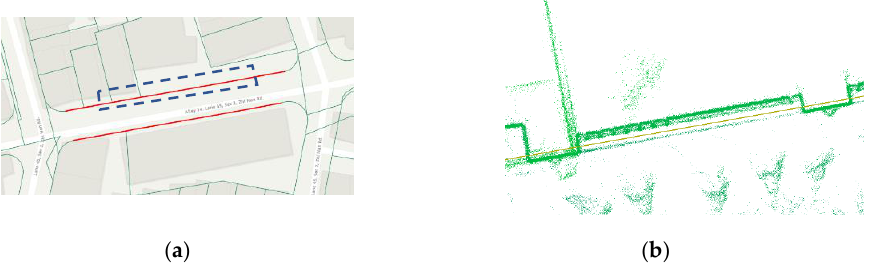
Figure 23. Possible cadastral detail line on an existing road boundary. ( a ) The digitized possible cadastral lines. ( b ) Overlap of point cloud and the cadastral map.